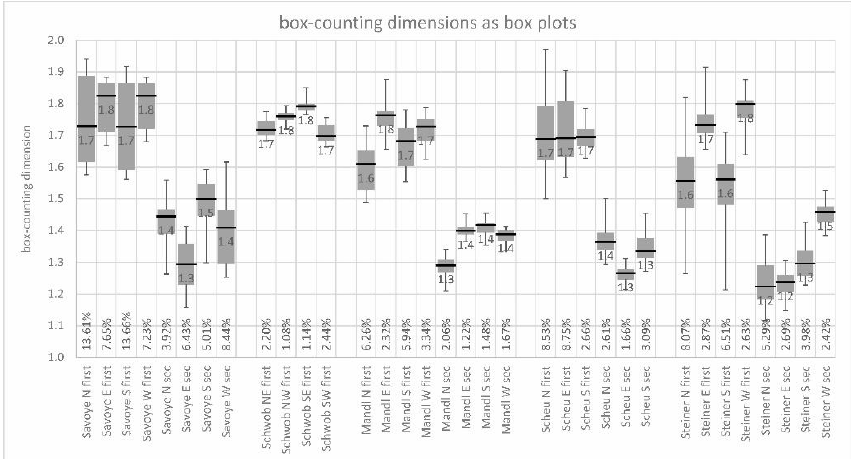
Figure 14. Box-plot of measurement series using values of straight data curve. The value in the box plot gives the median, the percentage at the bottom gives the interquartile range in relation to the value two.